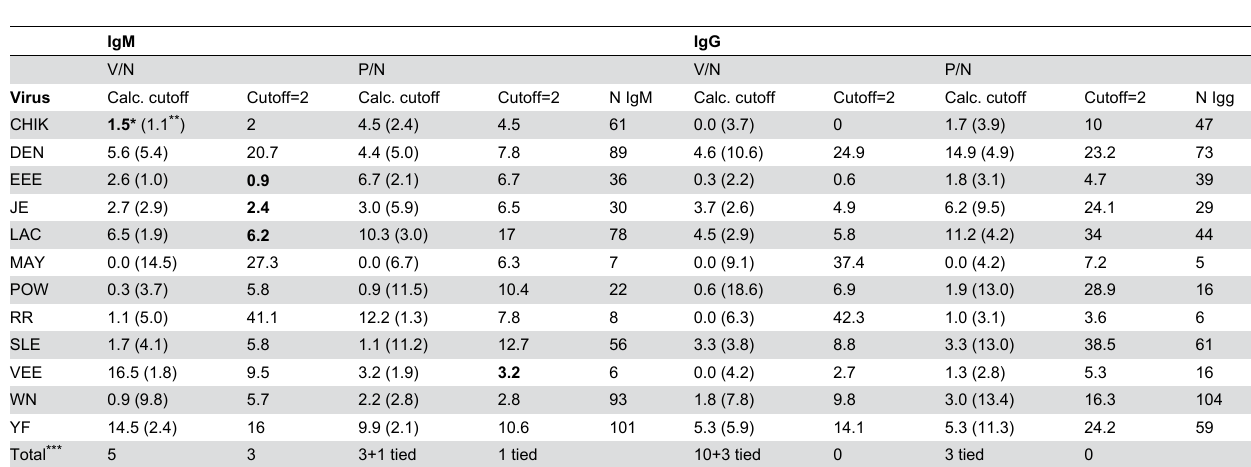
Table 6. Comparison of apparent error rates (%) generated by using calculated ROC cutoffs and cutoffs of